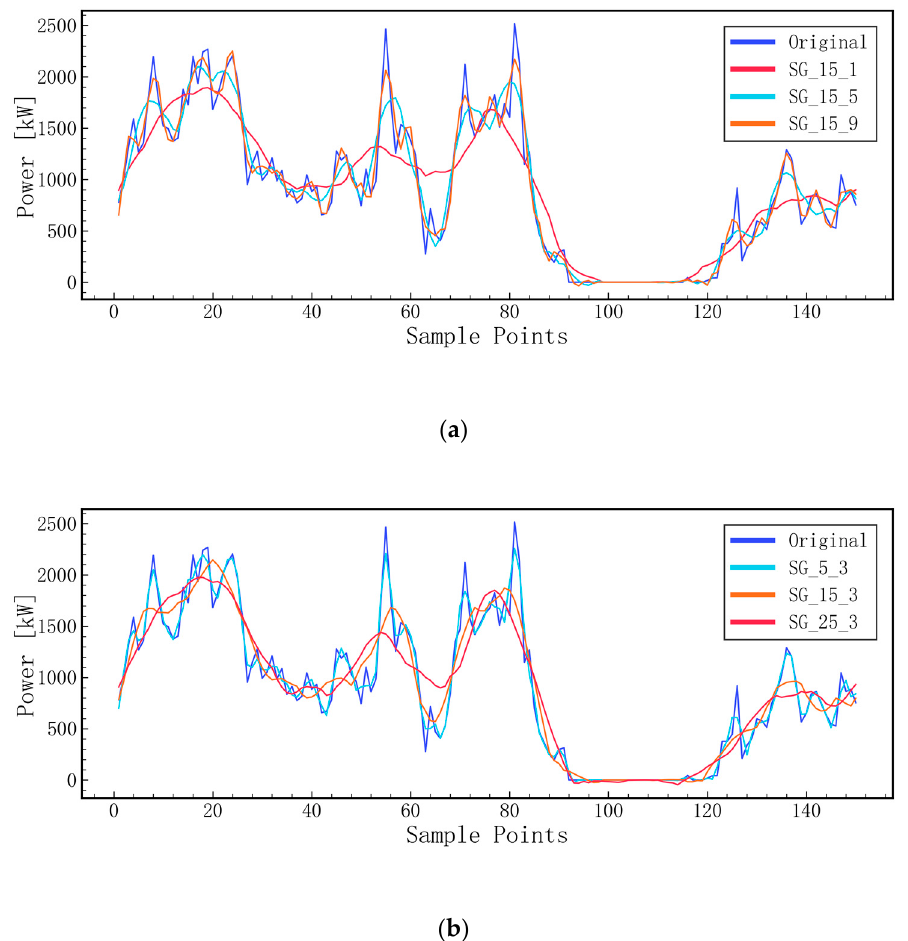
Figure 10. Diagram of the effect of digital filtering. ( a ) The processing effect of filters with the same frame length but different orders. ( b ) The processing effect of filters with the same order but different frame lengths.